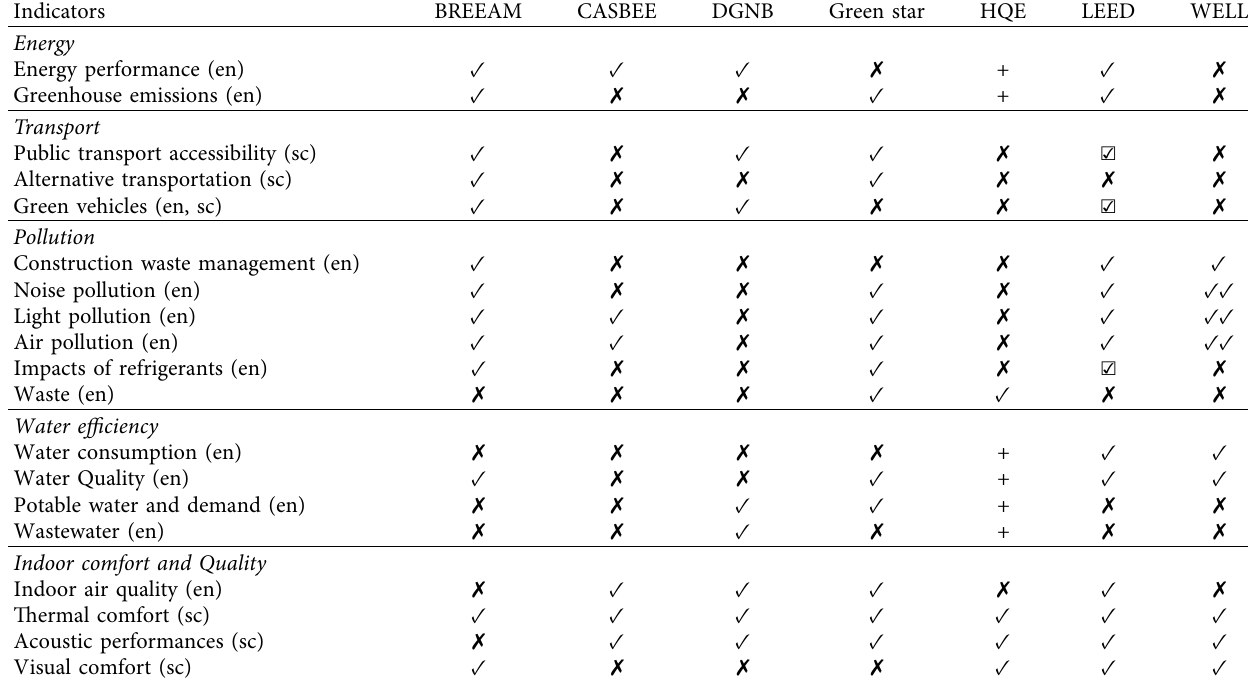
Table 6: Distribution of indicators under assessment